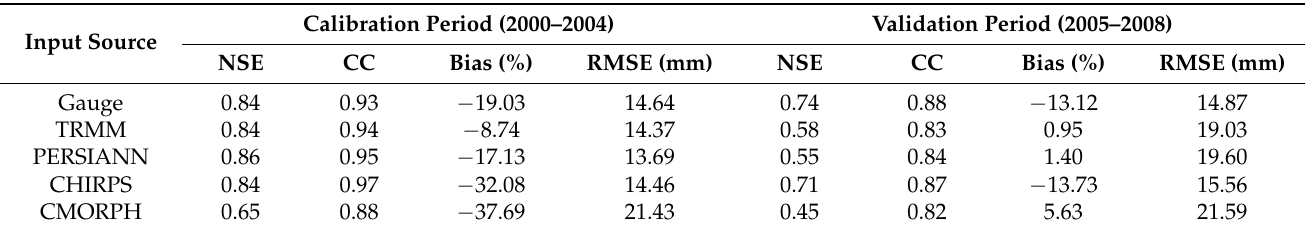
Table 3. The metrics for the monthly runoff simulation for four products and gauge at Lhasa